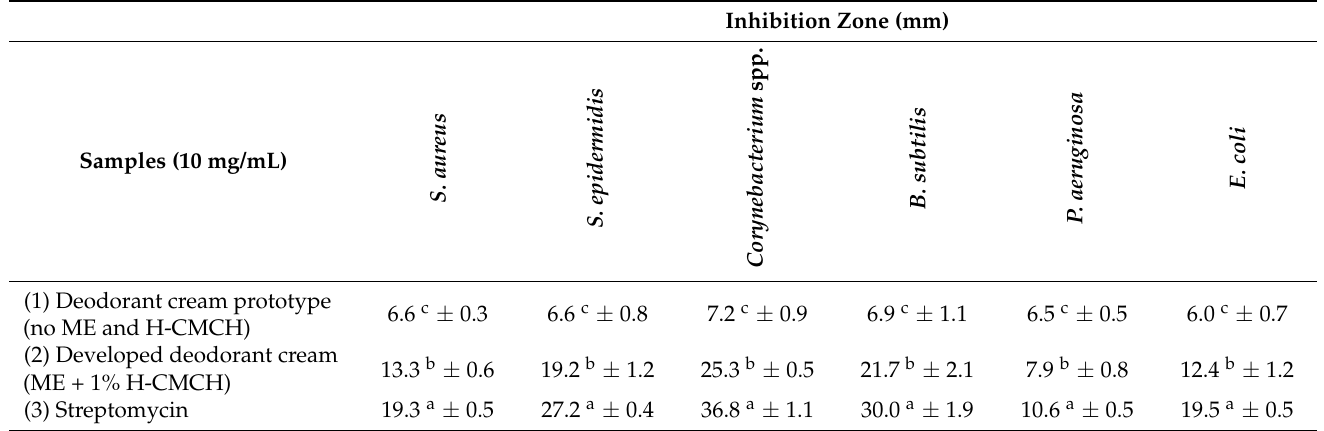
Table 3. Inhibition zone of prototype deodorant cream and developed deodorant cream.